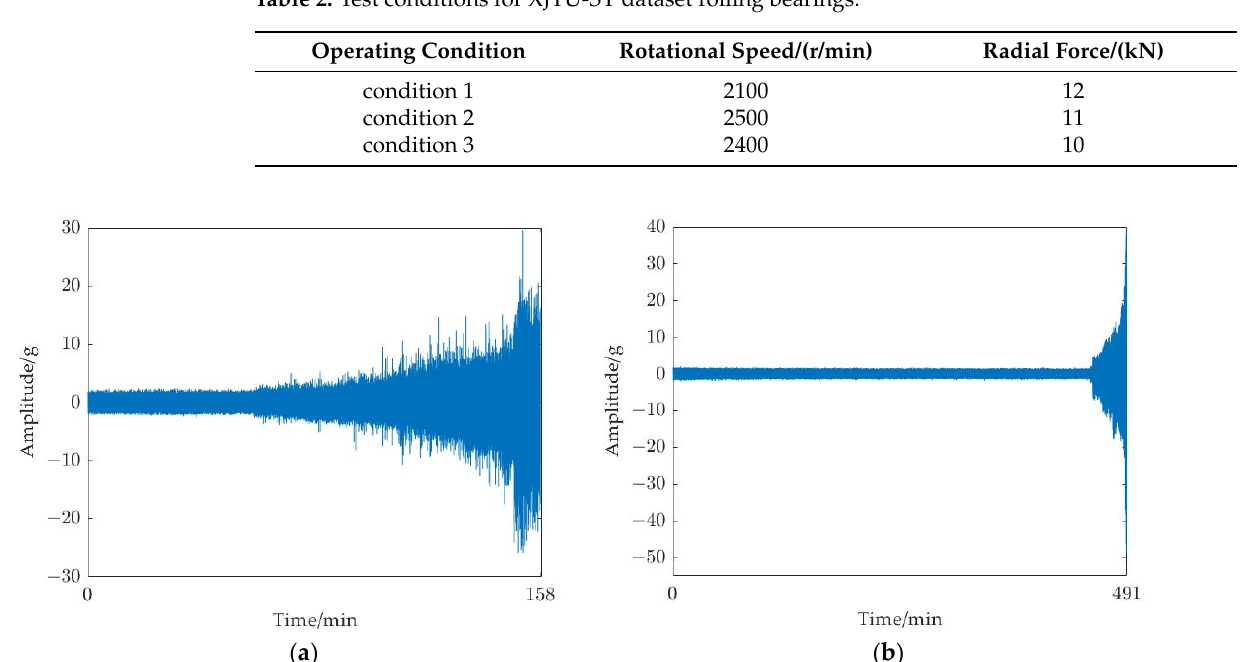
Figure 6. Time domain diagram of rolling bearings for test: ( a ) bearing1_3; and ( b ) bearing2_1.